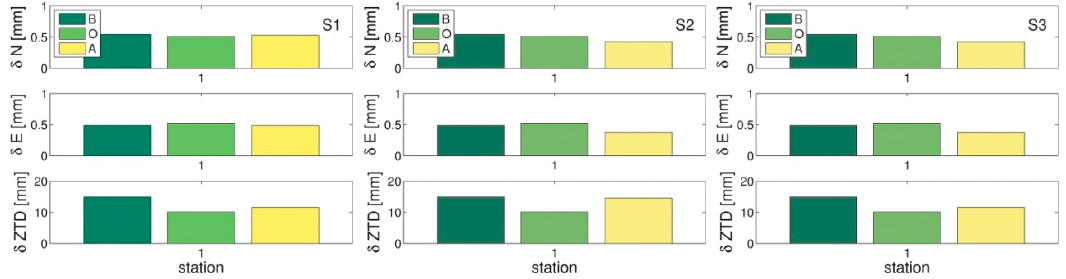
Figure 3. The root mean square errors of ZTDs and the horizontal delay gradients for the Background (B), the Observation (O) and the Analysis (A). Left panel: ZTDs are assimilated. Middle panel: Horizontal delay gradients are assimilated. Right panel: ZTDs and horizontal delay gradients are assimilated. Data from the single station Potsdam are assimilated four times per day (0, 6, 12, 18 UTC) for a period of two months (June and July, 2017).